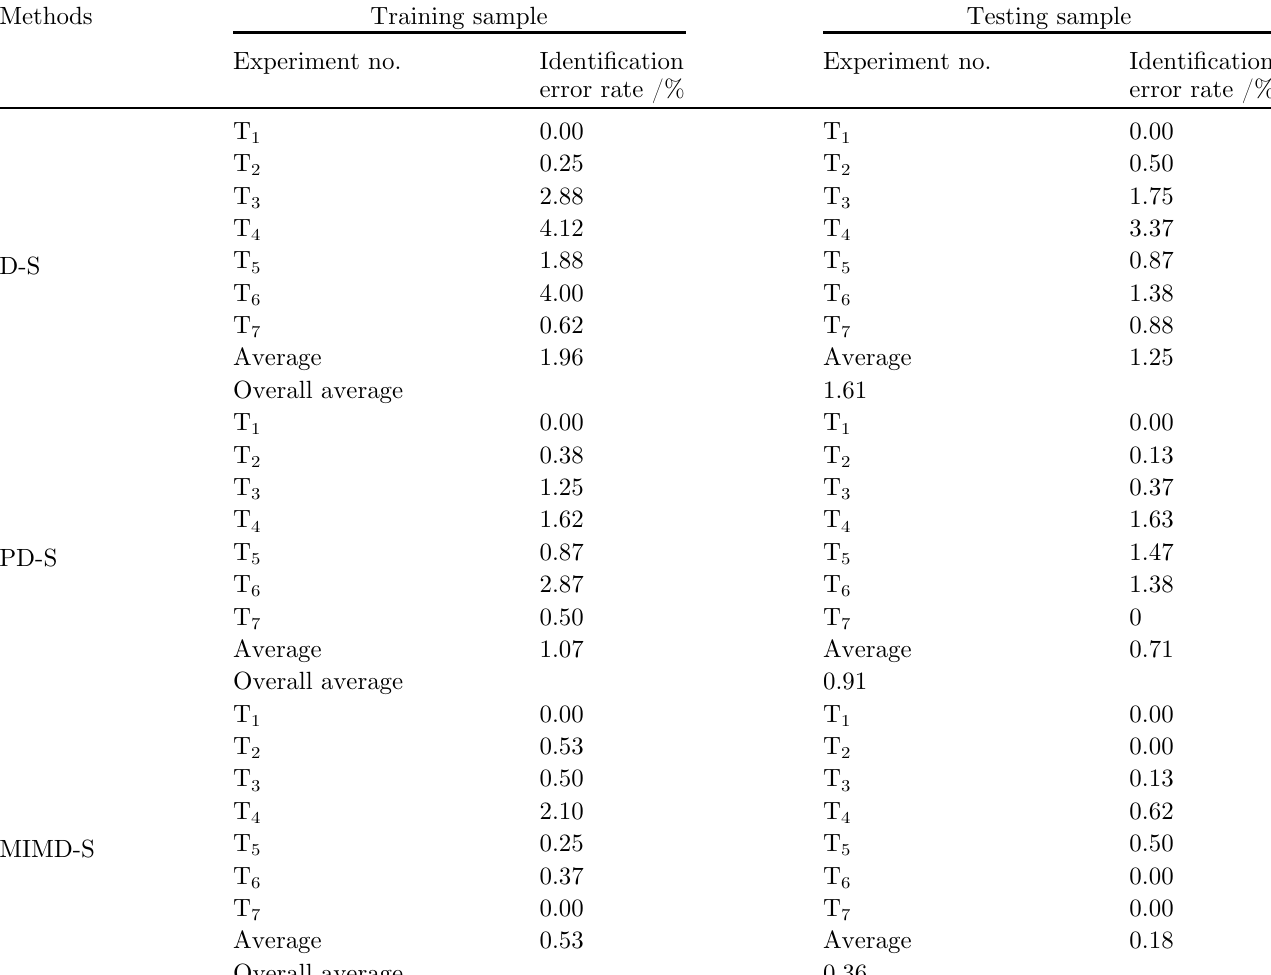
Table 5. Identi fi cation